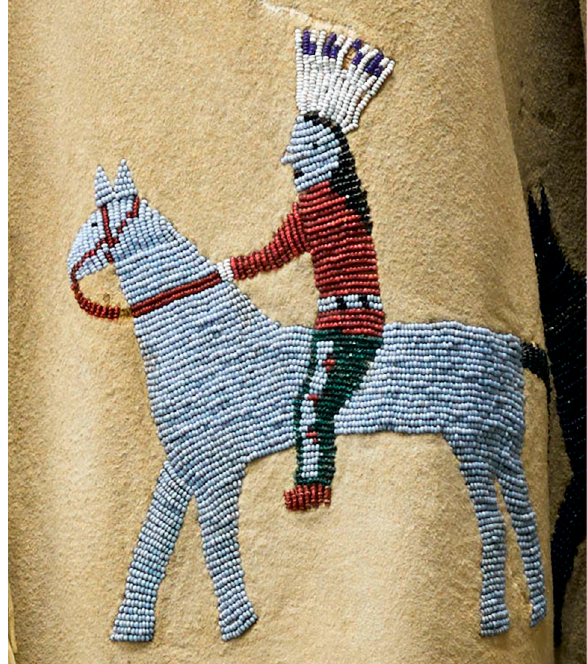
Figure 9. Regalia of It ȟ ú ŋ kasa ŋ Glešká (Detail of Figure 2a). Late nineteenth or early twentieth century. Buckskin and beadwork. Musée franco-américaine du château de Blérancourt. Photograph taken by Adrien Didierjean and used by permission of RMN-Grand Palais/Art Resource, NY. Arts 2019 , 8 , x FOR PEER REVIEW